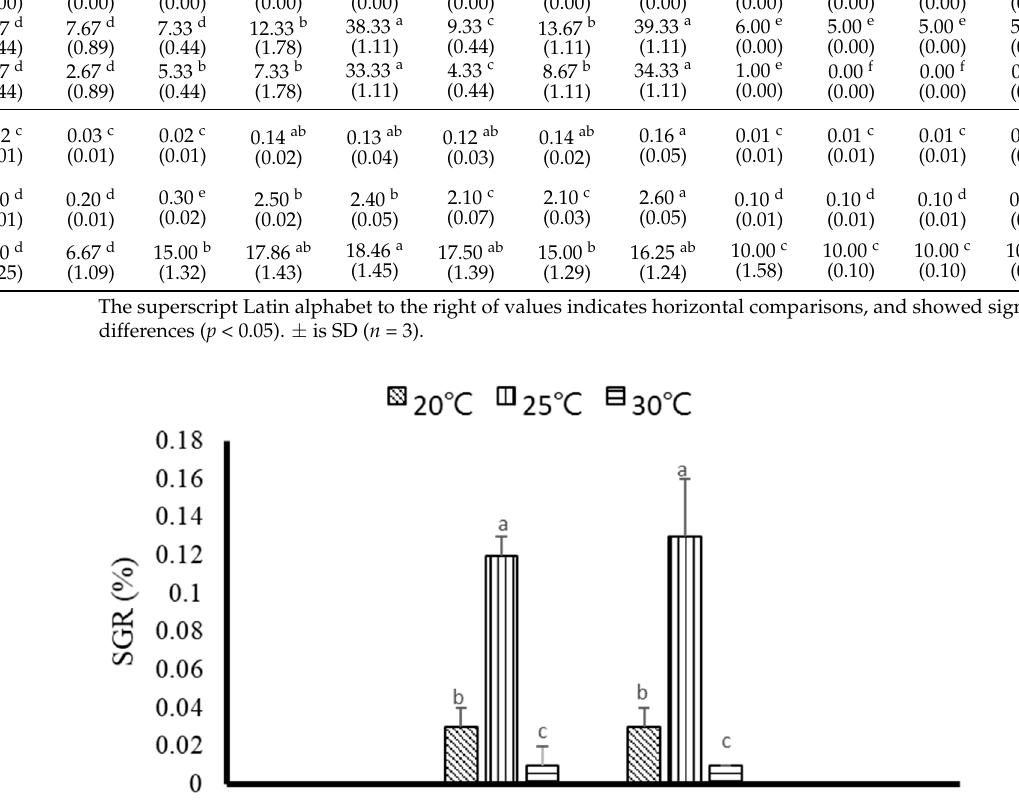
Table 2. Growth, ammonia excretion, oxygen consumption and energy metabolism rate of G. columna after 8 weeks of rearing at different temperatures and salinities. Salinity and Temperature 25 psu 30 psu 35 psu 40 psu